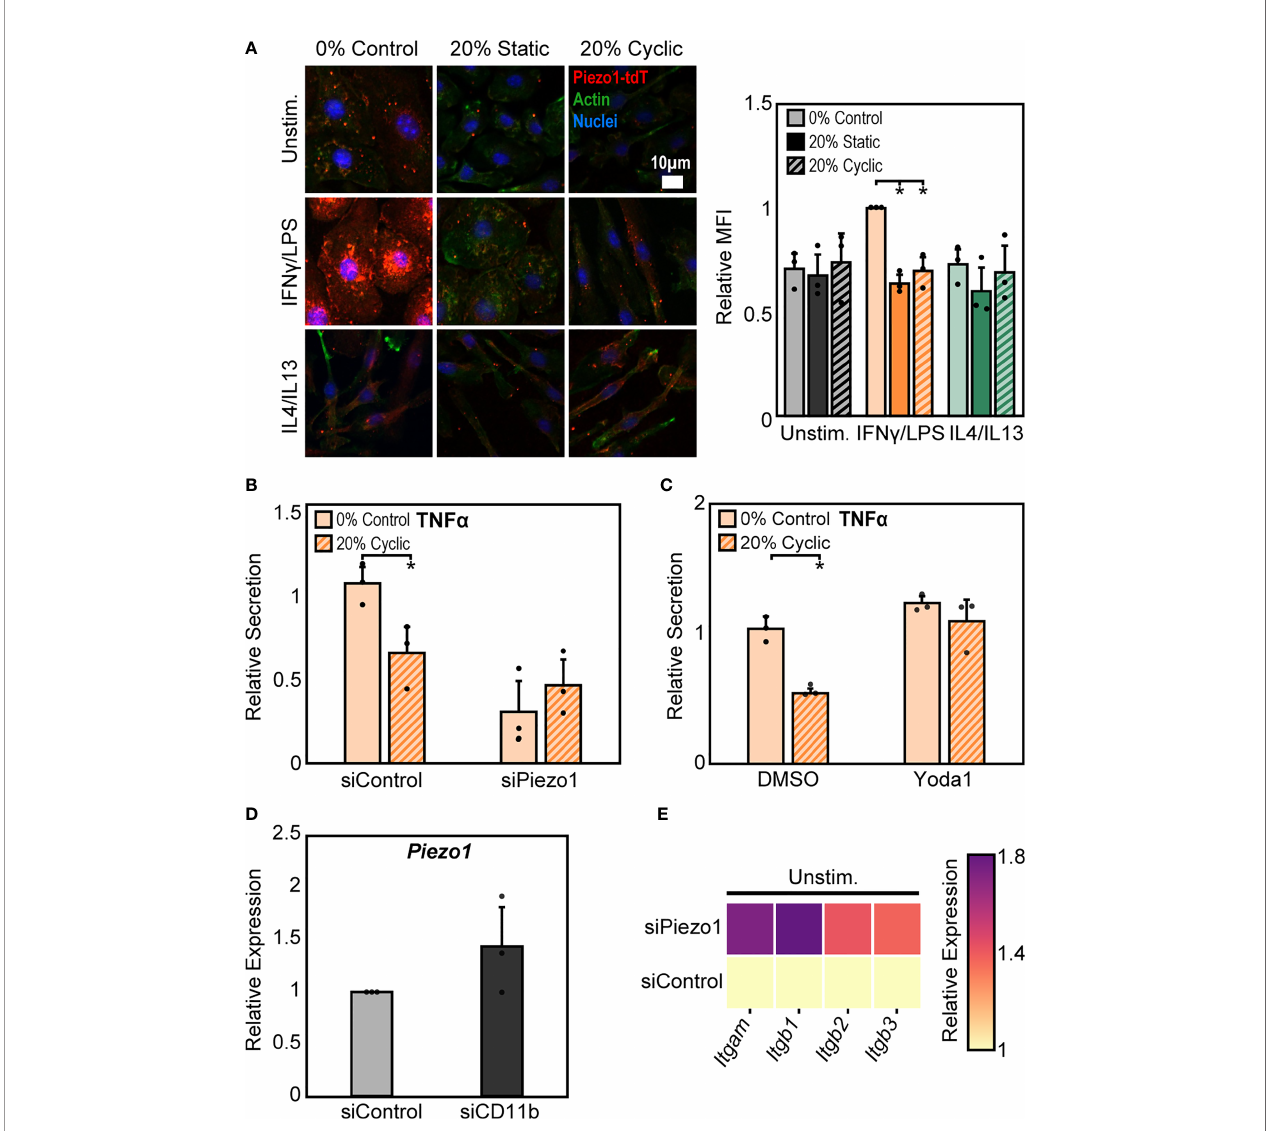
FIGURE 5 | Crosstalk between Piezo1 and CD11b mediates macrophage response to stretch. (A) Representative immuno fl uorescence images (left) and quanti fi cation of mean Piezo1-tdT intensity in unstimulated, IFN g /LPS, and IL4/IL13 treated macrophages exposed to 0% control, 20% static, or 20% cyclic stretch. Data normalized to the 0% control condition. (B) Secretion of TNF a in IFN g /LPS stimulated macrophages treated with siControl or siPiezo1 and exposed to either 0% or 20% cyclic stretch. Data normalized to a siControl treated internal control exposed to 0% stretch within each biological replicate. (C) Secretion of TNF a in IFN g /LPS stimulated macrophages treated with DMSO or Yoda1 and exposed to either 0% or 20% cyclic stretch. Data normalized to a DMSO treated internal control exposed to 0% stretch within each biological replicate. (D) Relative Piezo1 gene expression in unstimulated macrophages treated with non-target (siControl) or CD11b (siCD11b) siRNA. Gene expression is normalized to the siControl treated condition. (E) Relative Itgam, Itgb1, Itgb2 , and Itgb3 gene expression in unstimulated and siControl or siPiezo1 treated macrophages. Gene expression is normalized to the siControl treated condition. Error bars indicate standard deviation of the mean for three separate experiments and * p < 0.05 when compared to the corresponding 0% stretch condition as determined by Student ’ s